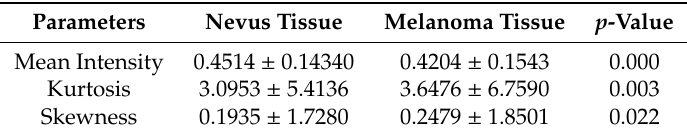
Table 1. First-order statistics.